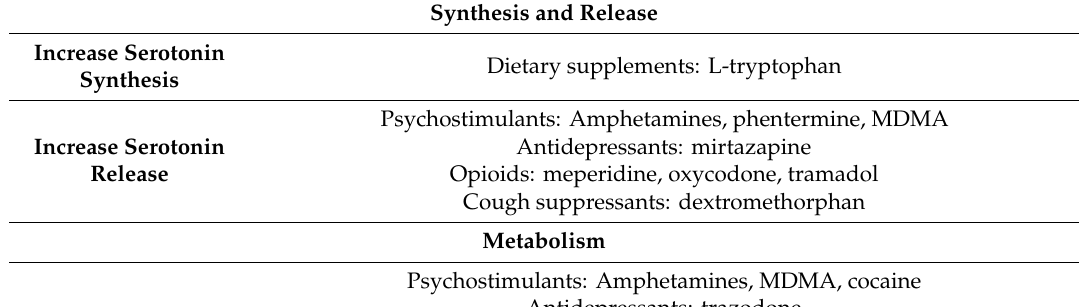
Table 3. Drugs associated with development of serotonin syndrome, classified according to their mechanism of